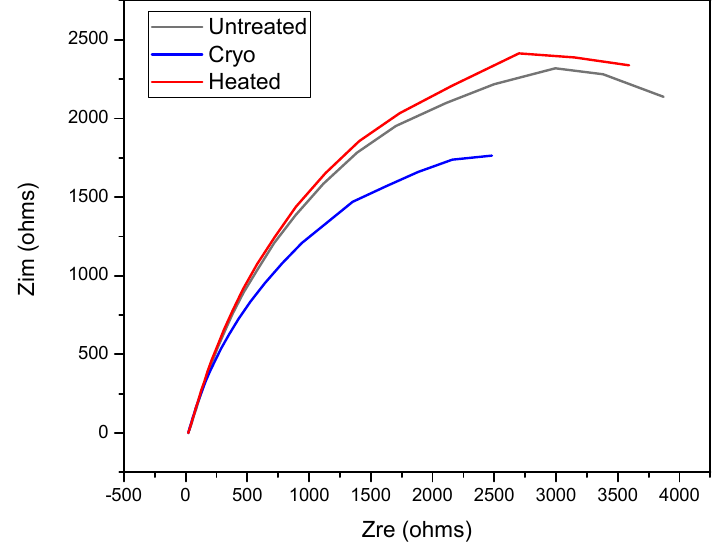
Figure 8. Nyquist plot for the investigated specimens.